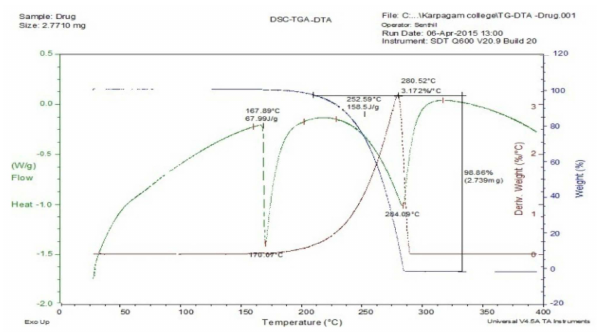
Figure 3. DSC, TGA, DTA of